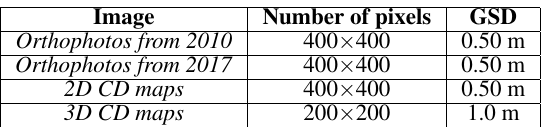
Table 2. Percentage of pixels characterised by ’change’ and ’no